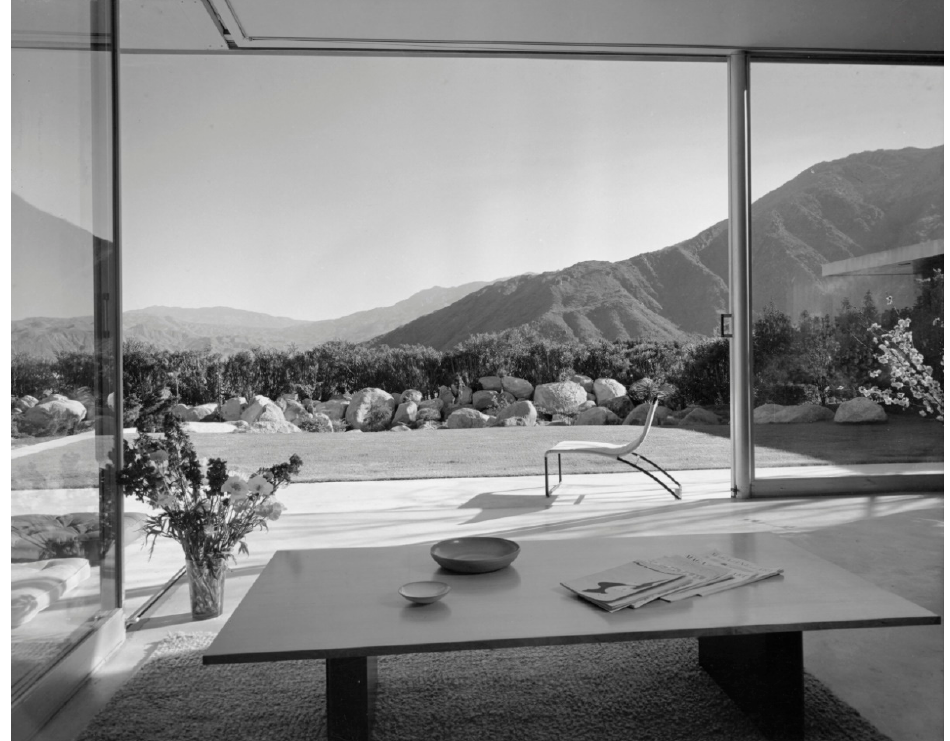
Figure 3. Richard Neutra, Kaufmann Desert House, Palm Springs, 1946–1947. View from living room. The oleander hedge hides the street but not the foothills. (Photo by Julius Shulman, job 093-30, © J. Paul Getty Trust. Getty Research Institute, Los Angeles, 2004.R.10).